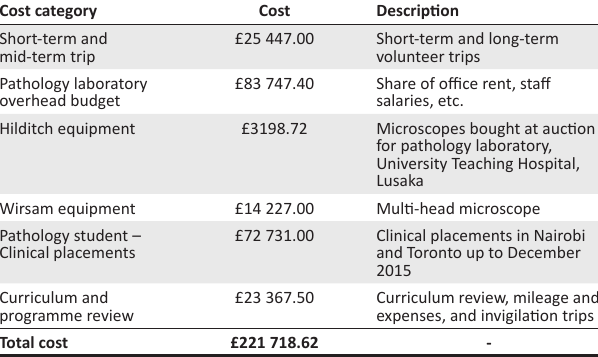
TABLE 1: Tropical Health Education Trust costs for development of MMed programme in Zambia, 2010–2016. Cost